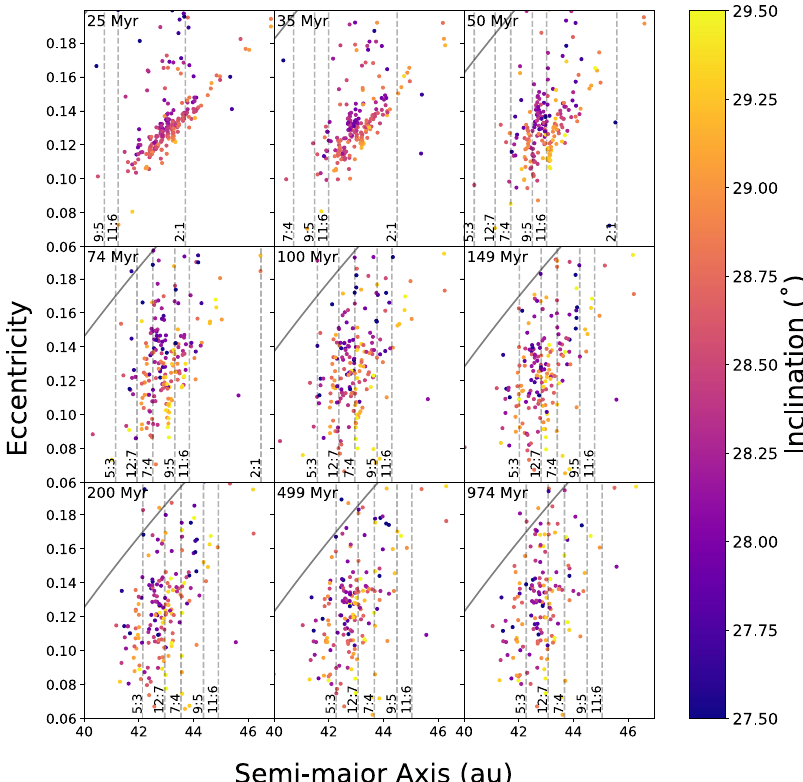
Fig. 2 Mixing of family members during migration. The averaged orbital elements throughout our integration. The orbital elements are found using a 50 Myr centered moving average of the instantaneous orbital elements of each object; this corresponds roughly to proper elements for non-resonant objects, though technically proper elements are not well-de fi ned for migrating planets. Each panel is labeled with the time in the top left, with Neptune ’ s jump occurring at 35 Myr. Note that the color bar deviates slightly from Fig. 1. In each frame, dashed, gray lines show the instantaneous locations of some of Neptune ’ s mean-motion resonances (MMRs). The diagonal, solid black line is an estimate of where scattering with Neptune becomes strong enough to remove objects (7/6 a N , corresponding to 35 au with a N = 30 au). For a comparison to the family without migration, see Fig. 1. In the fi rst panel, objects which have been captured into the 2:1 MMR are clearly migrating to higher eccentricities and lower inclinations (darker colors). In the second panel, at the time of the jump, the objects which were previously inside the 2:1 MMR have now been dropped out of resonance. Additional resonances passing through the family create chaotic diffusion in eccentricity over the next several panels, removing some of the a-e-i correlation and changing the tilted elliptical shapee5. Throughout this process, objects near resonances sometimes have their eccentricity excited, moving them into the unstable region where scattering becomes dominant. By the end of the integration, the original a-e-i correlation present in the planar family has been substantially obscured. Source data for this fi gure are provided as a Source data fi